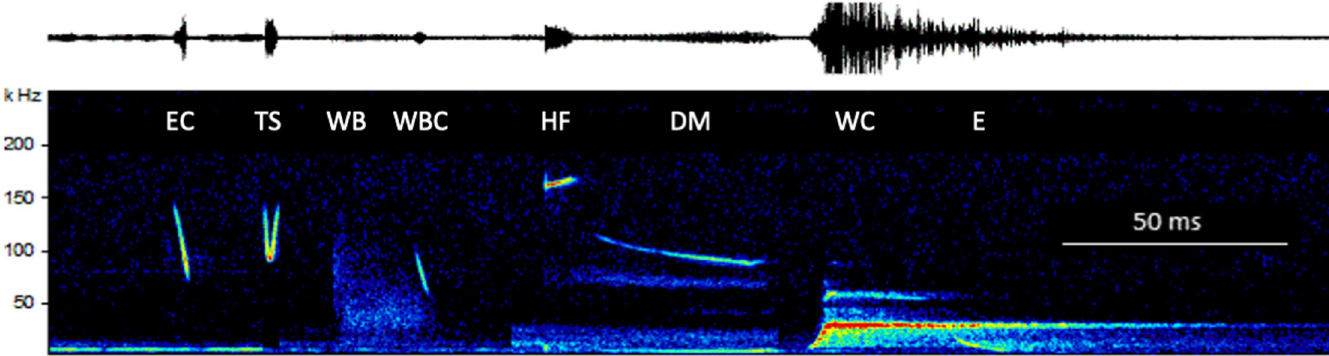
Fig 4. Syllables in the vocal repertoire of Centurio senex : Echolocation Call (EC), trill (TS), Wing Beat (WB) and associated Wing Beat Call (WBC), high frequency call (HF), downward modulated call (DM), Whistle Call (WC) and an end sweep (E).